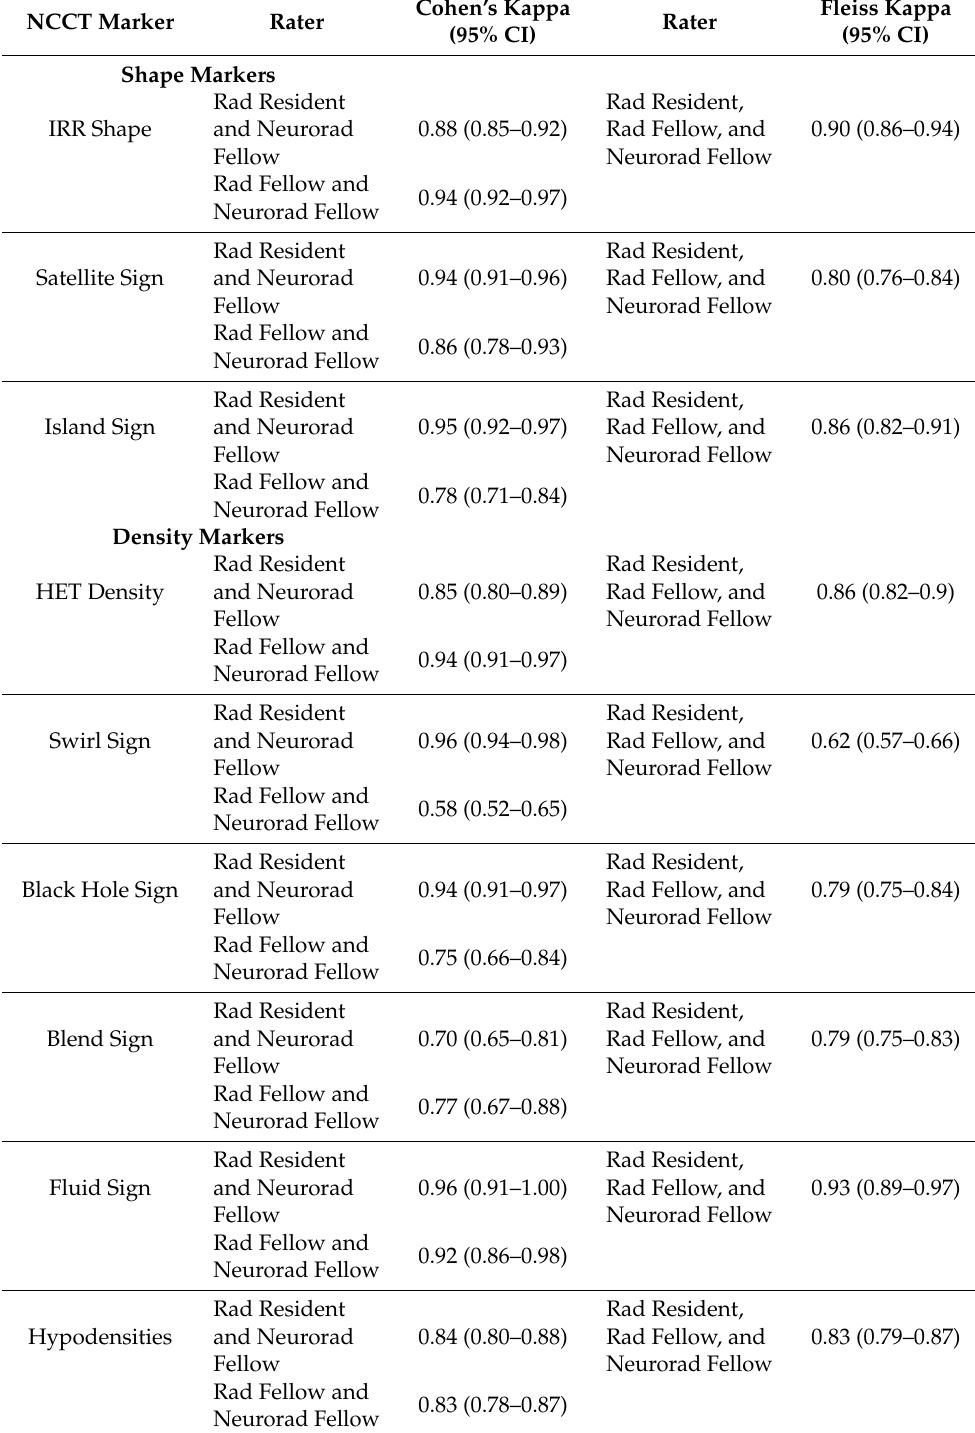
Table 3. Agreement of Noncontrast Computed Tomography markers across raters with different levels of experience stratified with Cohen’s kappa and the Fleiss